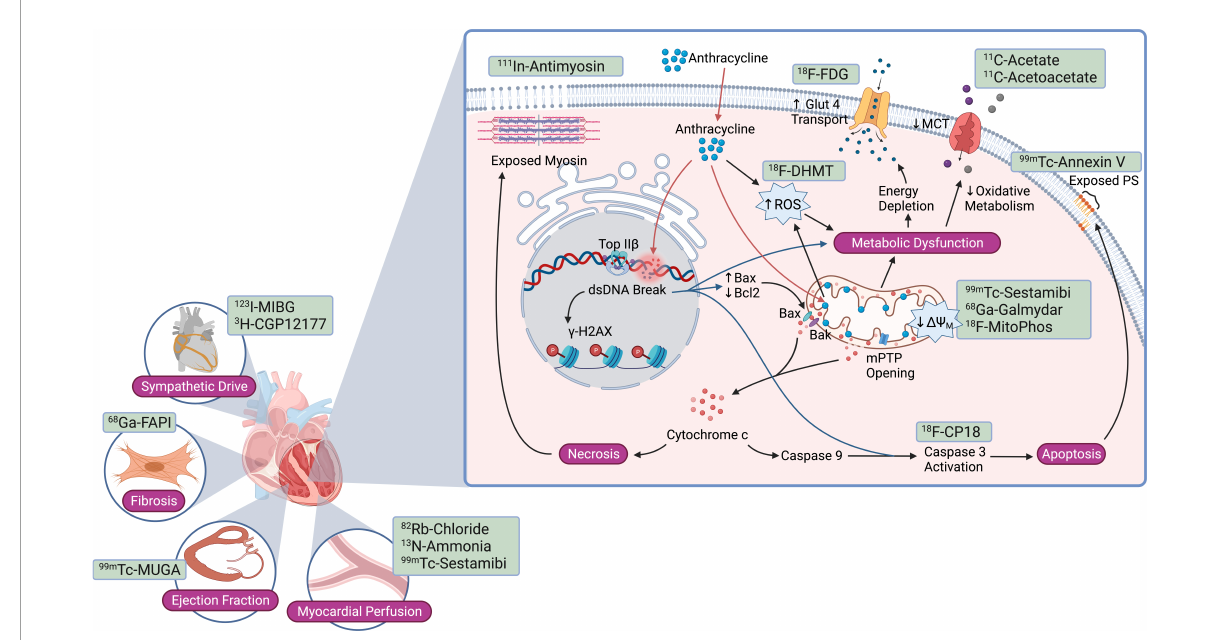
FIGURE1 Current nuclear molecular imaging strategies targeting pathways and cell injury mechanisms activated in anthracycline-induced cardiotoxicity. Nuclear probes studied to date target anthracycline-mediated cardiomyocyte injury mechanisms such as apoptosis, necrosis, reactive oxygen species, and mitochondrial dysfunction; downstream consequences such as cardiac fibrosis; and more global changes such as sympathetic drive, myocardial blood flow, and left ventricular ejection fraction. Bax, Bcl2 associated X protein; Bak, Bcl2 antagonist/killer; Bcl2, B-cell CLL/lymphoma 2; dsDNA, double-stranded DNA; GLUT1, glucose transporter 1; γ -H2AX, phosphorylated histone variant H2AX; MCT, monocarboxylate transporter; (cid:49)(cid:57) M , mitochondrial membrane potential; mPTP, mitochondrial permeability transition pore; PS, phosphatidylserine; ROS, reactive oxygen species; Top II β , topoisomerase II β